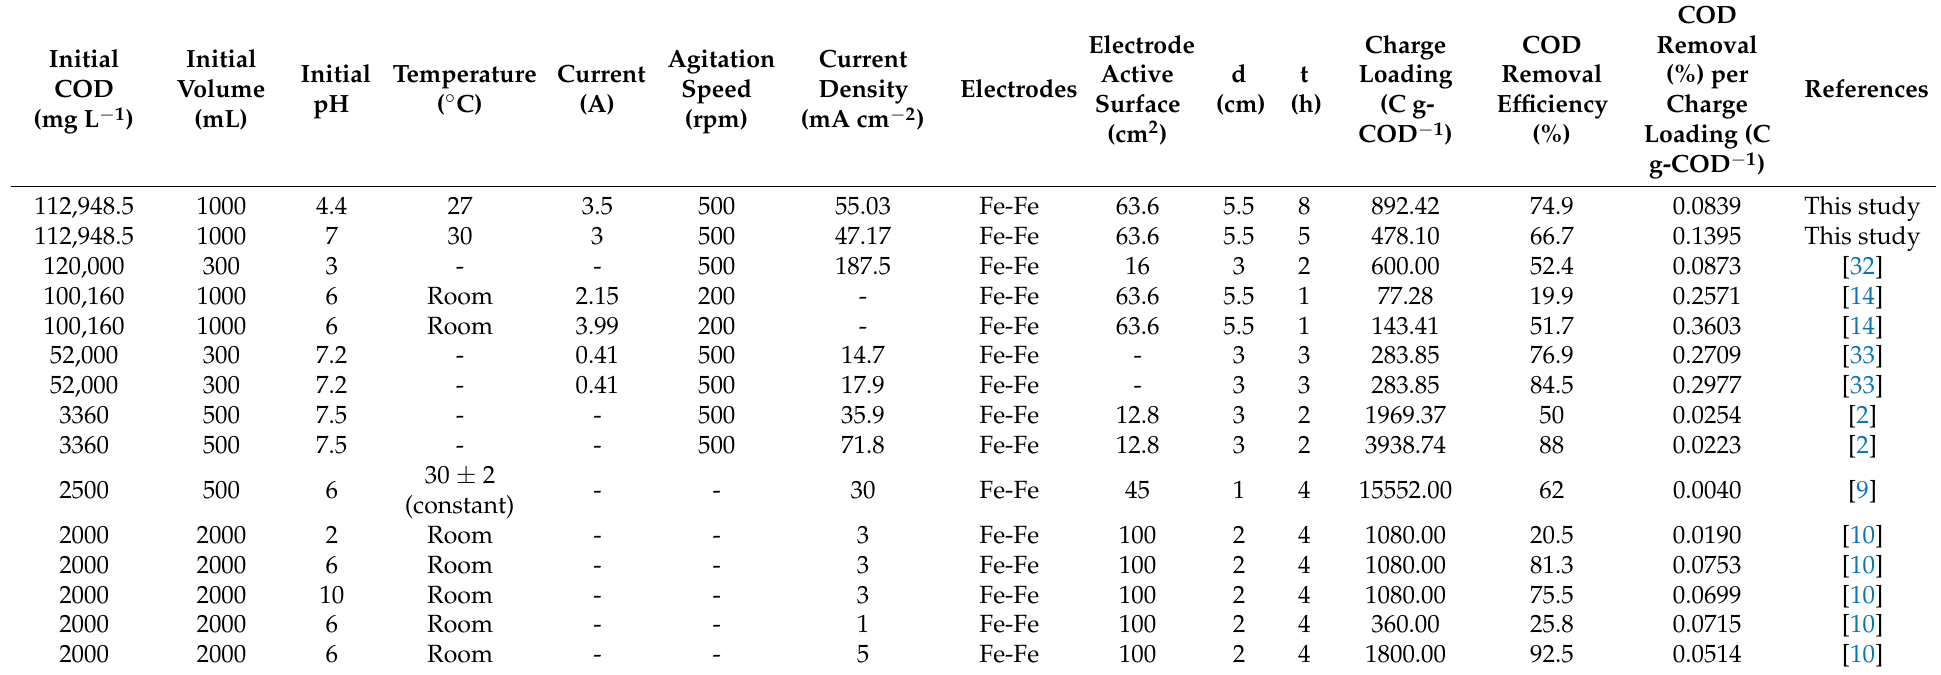
Table 6. Summary of the results in the EC of